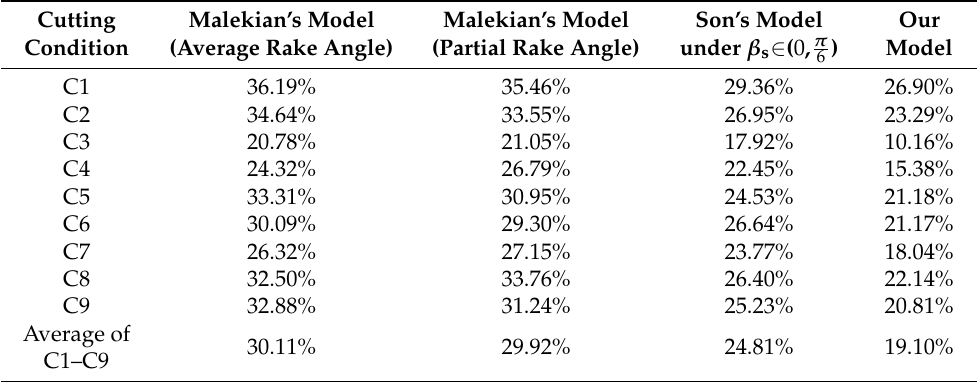
Table 5. The cutting force prediction error of different models.